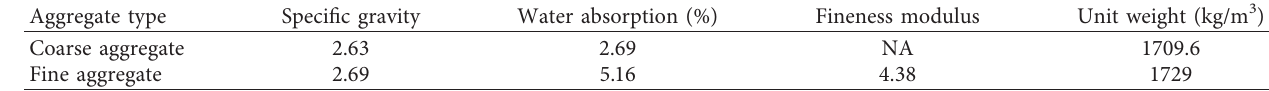
Table 2: Properties of mineral aggregates.